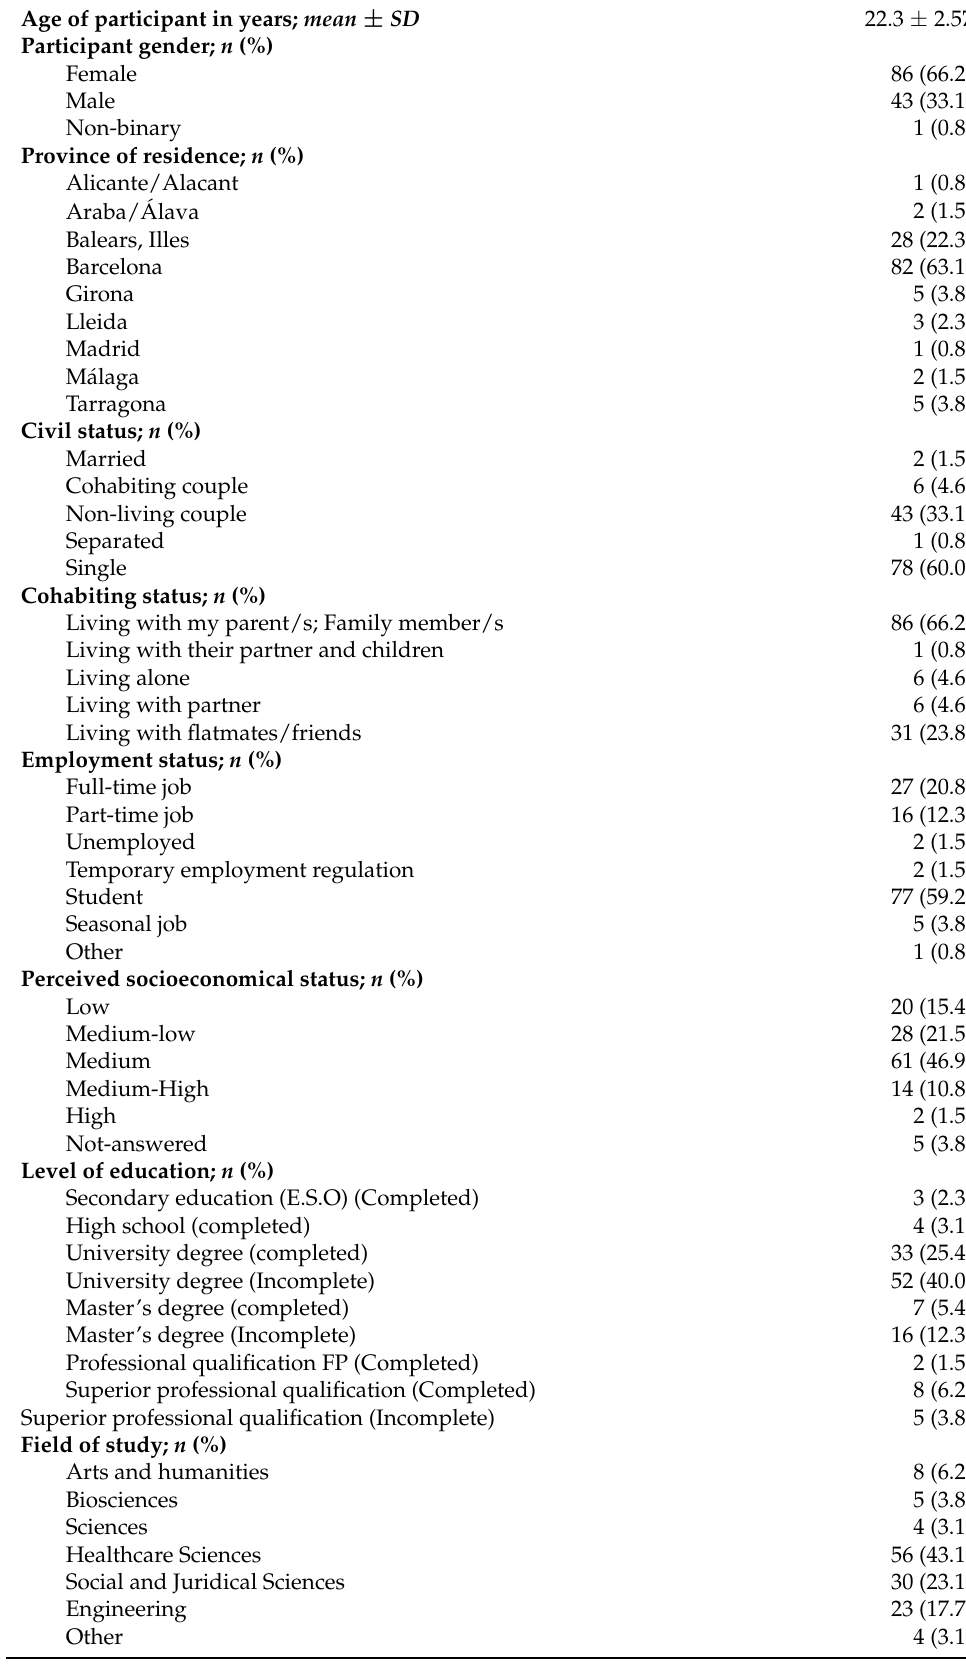
Table 1. Demographic characteristics of the